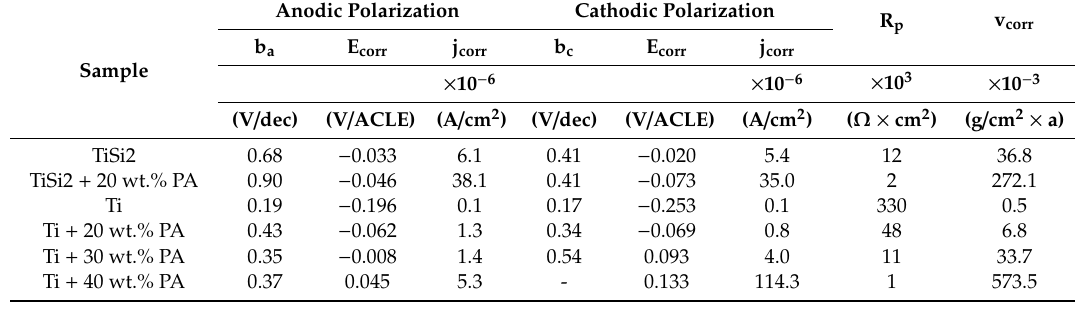
Table 5. Results of anodic and cathodic polarization.